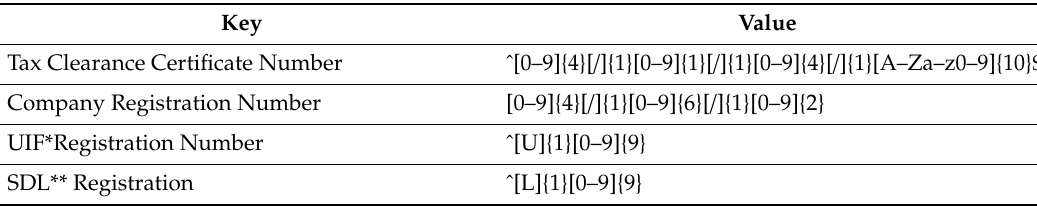
Table 2. Alias file containing a sample of field label and field-value (regex) mappings.